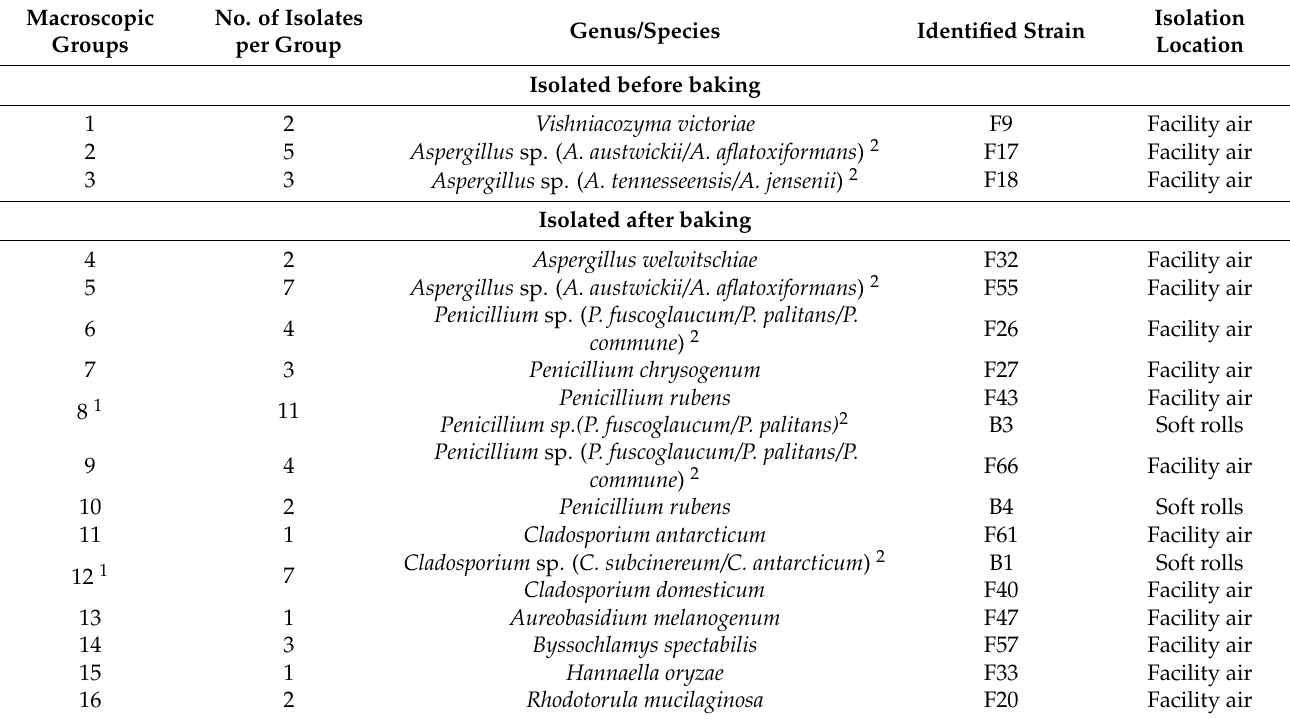
Table 2. Representative strains of 16 groups of 58 fungal contaminants isolated from ten different locations from facility air and soft rolls (produced without preservatives) and identified by sequence analyses of the ITS